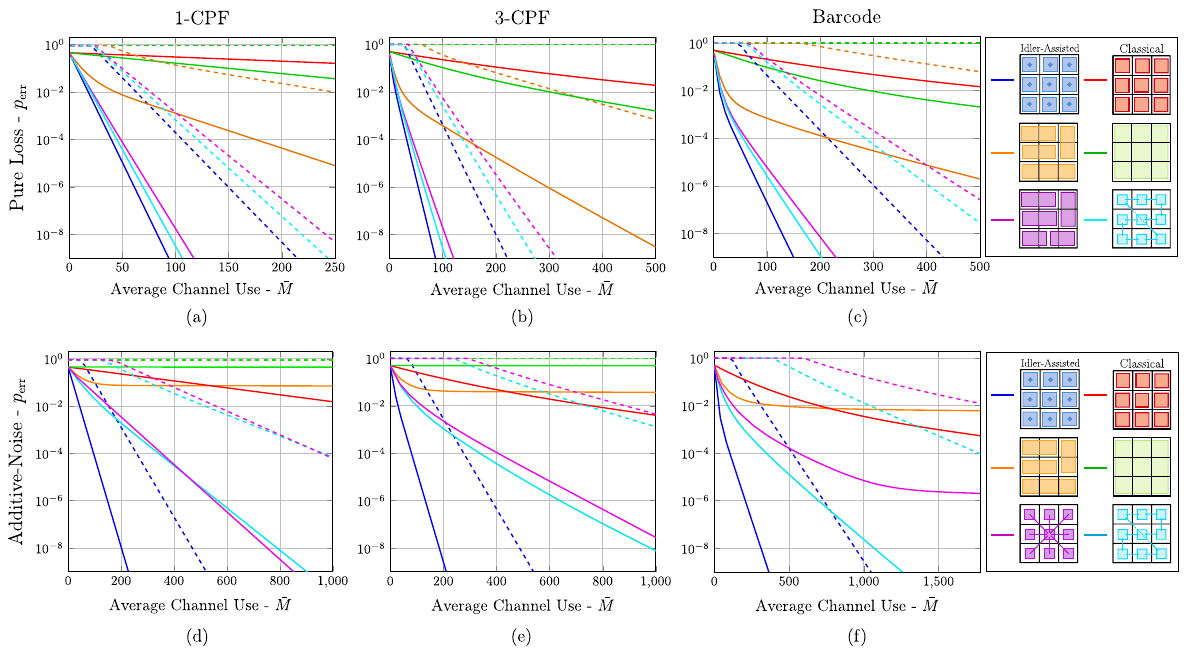
Fig. 4 Discrimination of Bosonic Gaussian channel patterns. Classi fi cation error bounds for CPF/pattern recognition of m = 9 channel patterns of a – c pure-loss channels with parameters η T , η B = 0.97, 0.99 and d – f additive-noise channels with parameters ν T , ν B = 0.01, 0.02, using probe states of mean photon energy N S = 20 and variable structures based on CV-GHZ states (and optimal classical states). All solid lines are lower bounds and all dashed lines are upper bounds, based on Eqs. (3) and (4), respectively. All input state structures are de fi ned diagrammatically in the respective